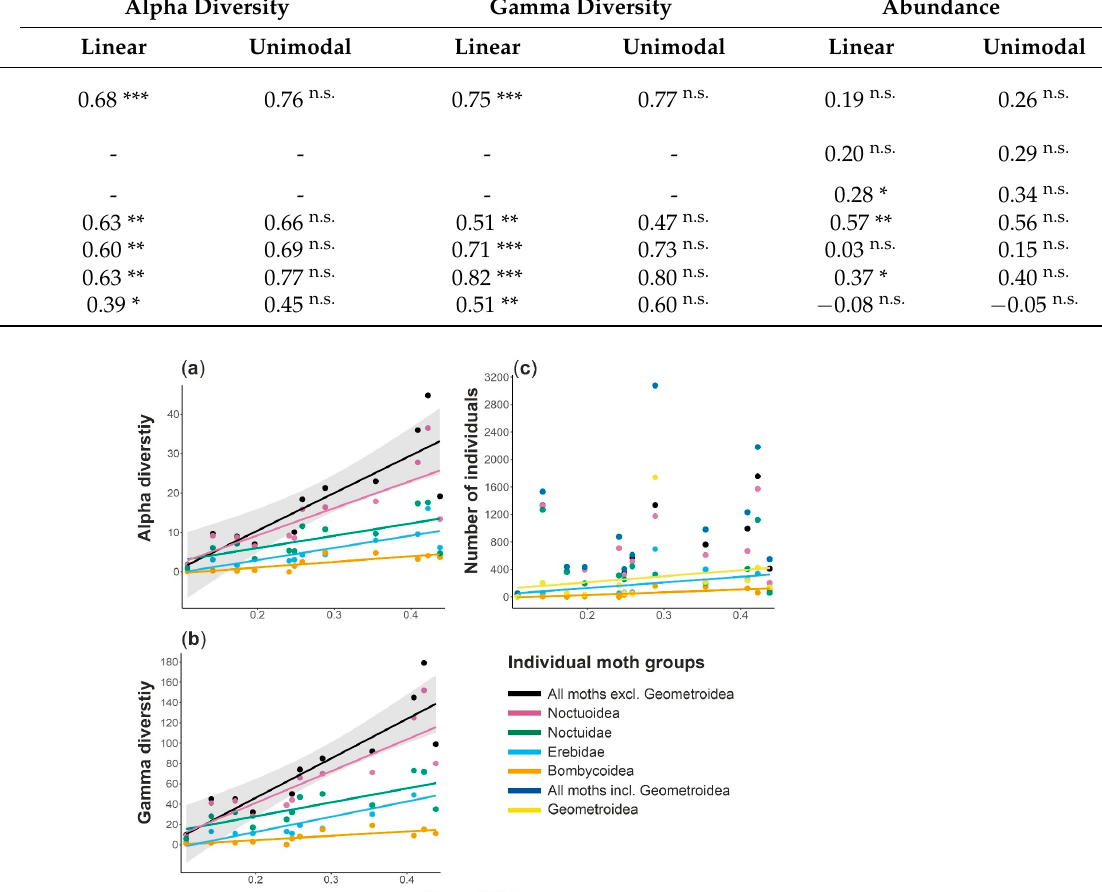
Table 3. Results of linear and unimodal models for relationship of moth diversity indexes (alpha diversity, gamma diversity, and abundance) to mean NDVI for each focal moth group. Coefficients of determination (R 2 ) are indicated, with the model p -values ( n.s. p ≥ 0.05, * p < 0.05; ** p < 0.01, *** p < 0.001).